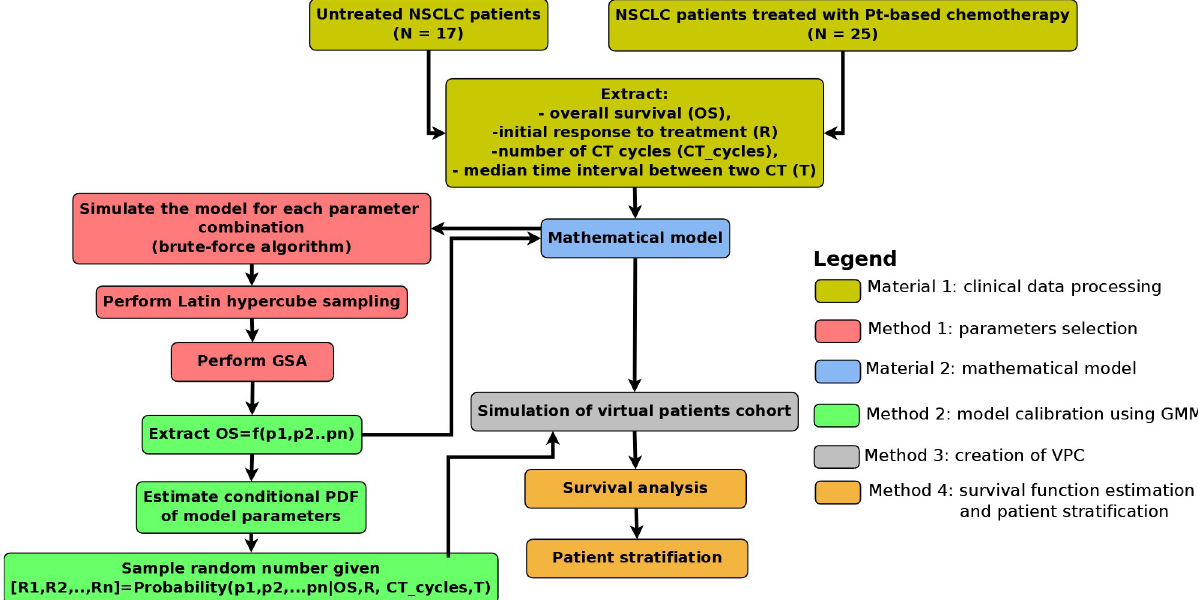
Fig 1. Computational framework. The diagram shows the flowchart of the computation. In the first step, the clinical data from NH and CT cohorts are merged. Next, the data are applied to estimate the probability density function (PDF) of CT the next step, joint PDF, P ( DT,σ|OS ) is estimated using a combination of brute-force algorithm and GMM. The second and third steps provide the possibility to create virtual patients (VPs), who are then simulated from diagnosis until clinical death. In the last step, Kaplan-Meier analysis is performed and patients are stratified. The details of the computational framework are presented in the Materials and Methods section as well as in the Supplementary Text.